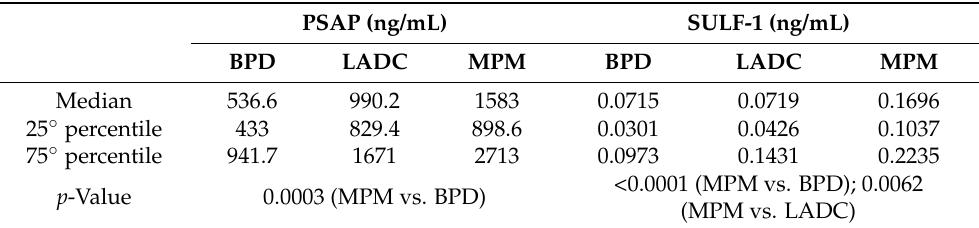
Figure 1. PSAP and SULF-1 concentrations in PE of MPM, lung ADC, and BPD patients. ( a ) PSAP levels were significantly higher in MPM patients than in BPD patients ( p = 0.0003). ( b ) SULF-1 levels were significantly higher in MPM patients than in BPD ( p < 0.0001) and lung ADC ( p = 0.0062) patients. ( c ) Taking into account all patients, PSAP levels significantly correlated to SULF-1 expression levels ( p < 0.0001 r = 0.404. The correlation was determined by simple logistic regression using the Likelihood-Ratio Test (LRT) (GraphPad Prism 8.0). Each data point represents mean of three independent experiments performed in duplicate. Statistical significance of the difference between groups was determined by the Mann-Whitney-Wilcoxon test. **, p < 0.01; ***, p < 0.001; ****, p < 0.0001. MPM, malignant pleural mesothelioma; LADC, lung adenocarcinoma; BPD, benign pleural disease. Table 2. Summary of PSAP and SULF-1 concentrations in patient pleural